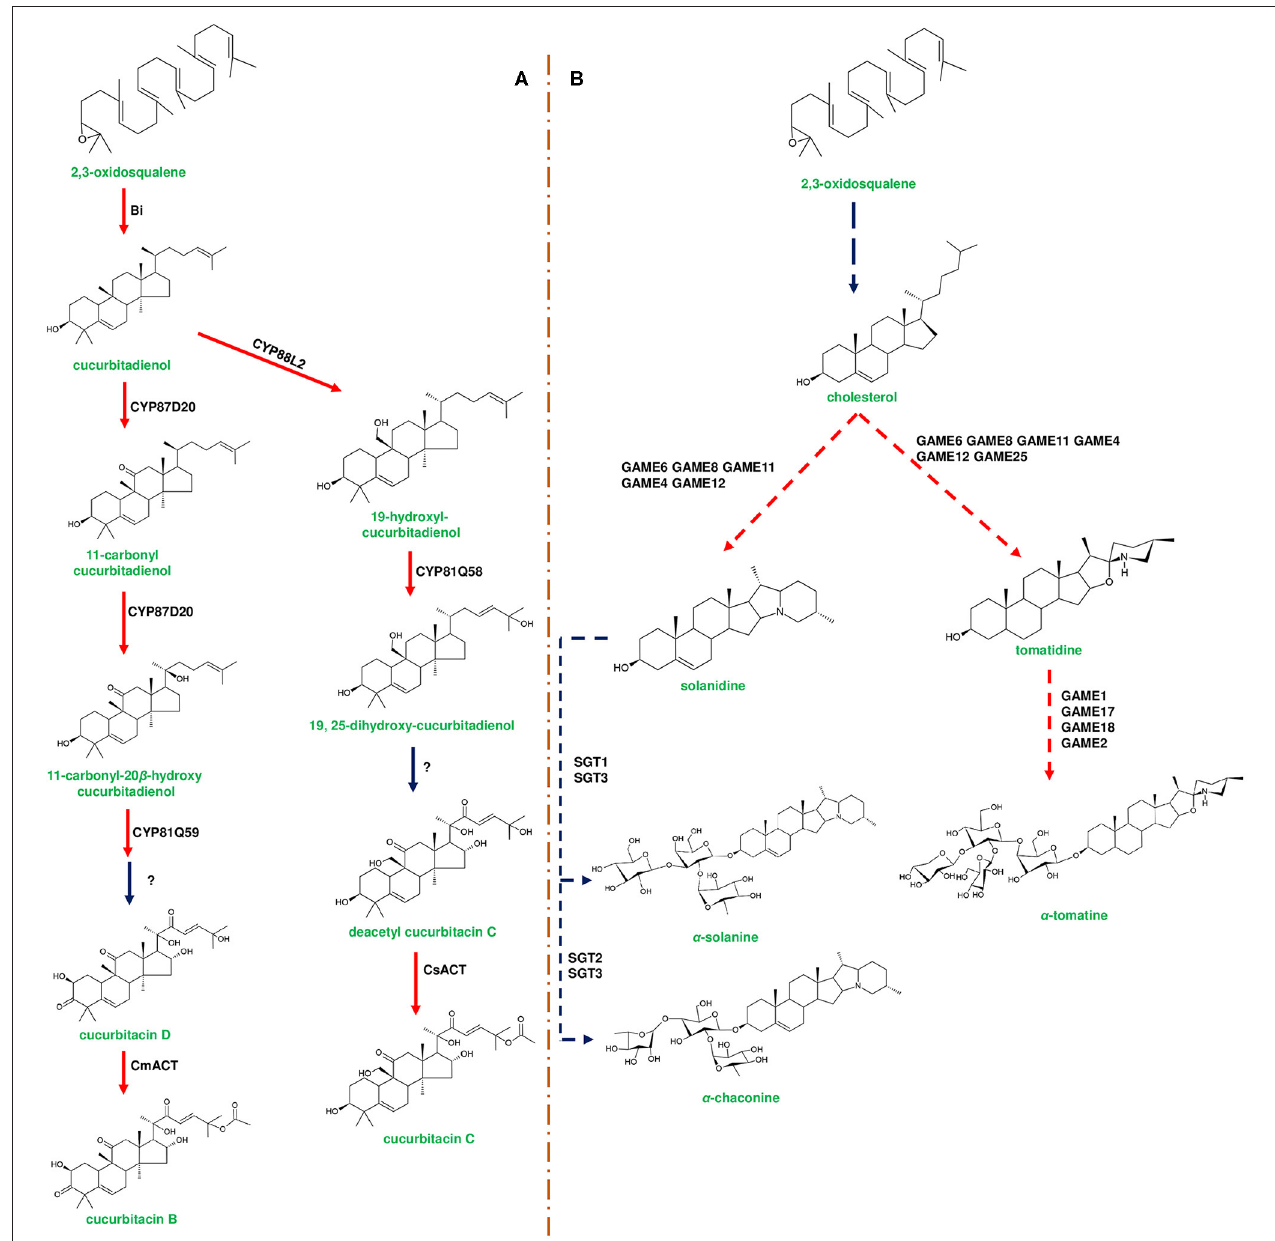
FIGURE 3 | Representative biosynthetic pathway of cucurbitacins in Cucurbitaceae and steroidal glycoalkaloids (SGAs) in Solanaceae . (A) represents the biosynthesis of cucurbitacins through enzymes encoded by the cucurbitacin gene cluster. The first step in cucurbitacin biosynthesis occurs by the enzymatic conversion of 2,3-oxidosqualene to cucurbitadienol mediated by enzyme Bitterness (Bi) belonging to oxidosqualene cyclase family. Cucurbitadienol is converted to cucurbitacin C (CuC) in Cucumis sativus mediated by CYP450s and acyltransferase [ C. sativus acyltransferase ( Cs ACT)]. In Cucumis melo , cucurbitadienol is converted to cucurbitacin B (CuB) by CYP450s and C. melo acyl transferase ( Cm ACT). Modification of the backbone in different Cucumis species is attributed to the activity of CYP450s. (B) represents the biosynthesis of SGAs from cholesterol using the enzymes encoded by the SGA gene cluster. α -solanine and α -chaconine are the signature metabolites of potato ( Solanum tuberosum ). In potato, cholesterol is converted to solanidine by catalytic reactions of GAME8 (glycoalkaloid metabolism), GAME6, GAME11, and GAME12. Further, solanidine is converted to α -solanine and α -chaconine by Sterol alkaloid glycosyl transferases (SGT1, SGT2, SGT3). α -tomatine is produced in Solanum lycopersicum (tomato) through a similar set of genes present in the SGA gene cluster. Tomatidine is formed by the modification of cholesterol mediated by GAME6, GAME8, GAME11, GAME4, GAME12, and GAME25, respectively. Tomatidine is conjugated with four sugar moieties [one moiety each of galactose and xylose and two moieties of glucose] by UDP-glycosyl transferases, GAME1, GAME17, GAME18, and GAME2, respectively. Genes of the plant metabolic cluster encoding enzymatic reactions are indicated in red arrows. Dotted arrows represent a multi-step pathway.